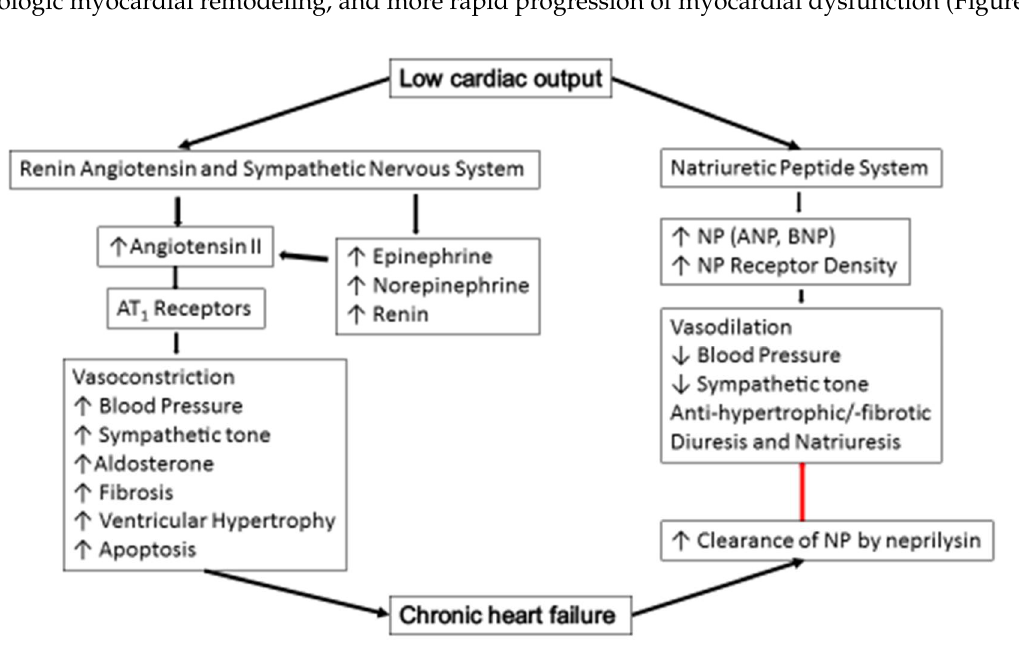
Figure 2. Pathophysiology of chronic heart failure. (AT 1 = angiotensinogen 1, ↑ = increase, ↓ = decrease, NP = natriuretic peptide, ANP = atrial natriuretic peptide, BNP = B-type natriuretic peptide).